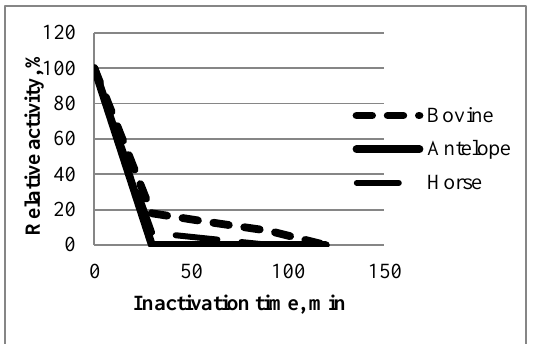
Figure 5. Acid influence on the enzyme